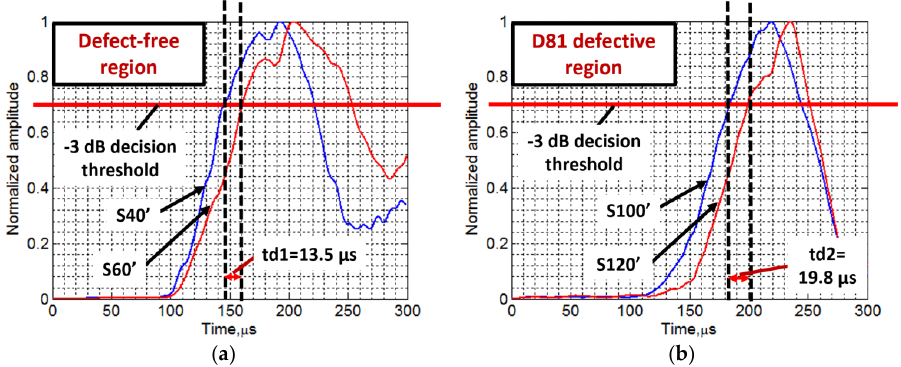
Figure 8. Comparison of instantaneous amplitudes of reconstructed signals: S40 ’ and S60 ’ of the defect-free region ( a ); and S100 ’ and S120 ’ of the D81 defective region ( b ). The arrival time of defect-free signals (S40 ’ and S60 ’ ) was observed as 146.5 µs and 160 µs , respectively, and, in the case of defective signals (S100 ’ and S120 ’ ) it was observed as 181.7 µs and 201.5 µs , respectively. Hence, the average time delay between the defect-free and defective signals is 38.35 µs.